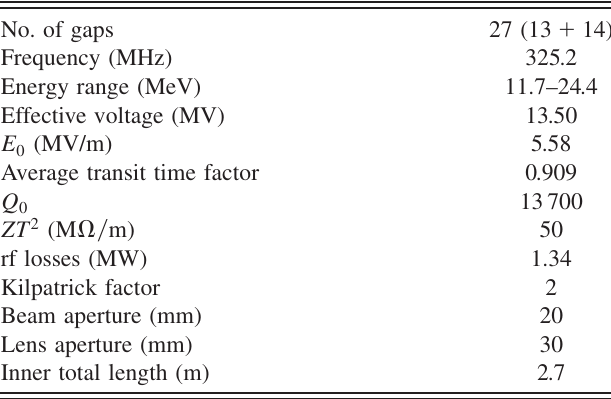
TABLE V. Main parameters of the second cavity of the FAIR proton injector. The rf parameters include a reduction safety margin of 15%. The length of the coupling cell is included in the definition of ZT 2 .